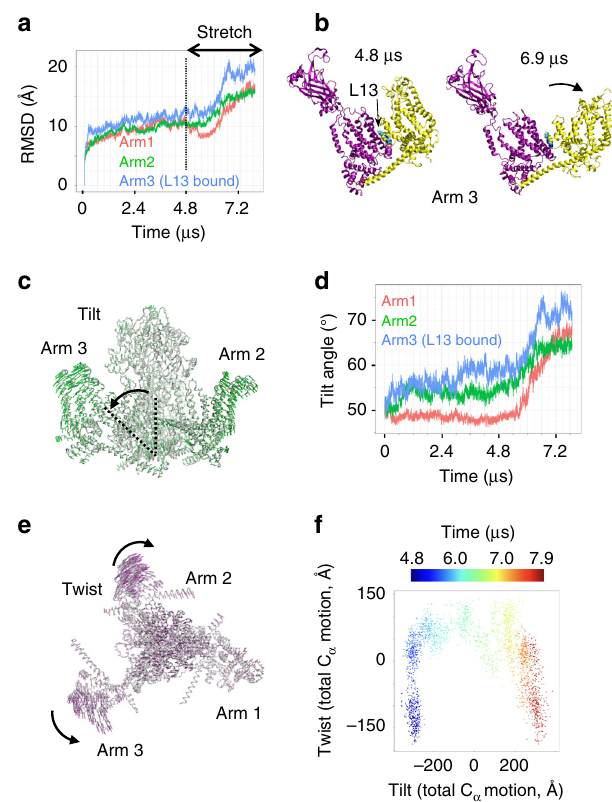
Fig. 5 Yoda1 facilitates tension-induced arm motions. a RMSD for each Piezo1 arm along the full multi-ligand trajectory. b Trajectory snapshots of the Yoda1-bound subunit (arm 3) taken before (4.8 µ s) or after (6.9 µ s) stretch. c PCA representation of tilt motions. The green arrows indicate the direction of tilt motions along the stretch region of the trajectory. d Time evolution of tilt angle for each arm along the multi-ligand trajectory. e PCA representation of twist motions. The purple arrows indicate the direction of twist motions along the stretch region of the trajectory. f 2-dimensional projection of tilt and twist motions (represented as total C α motion) colored as function of time during the stretch region of the trajectory. The 0 value in the tilt and twist axes represent the average position along the corresponding PCA